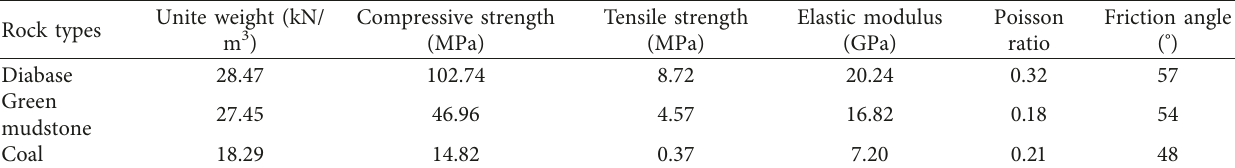
Table 1: Mechanical parameters of the prototype rock mas.